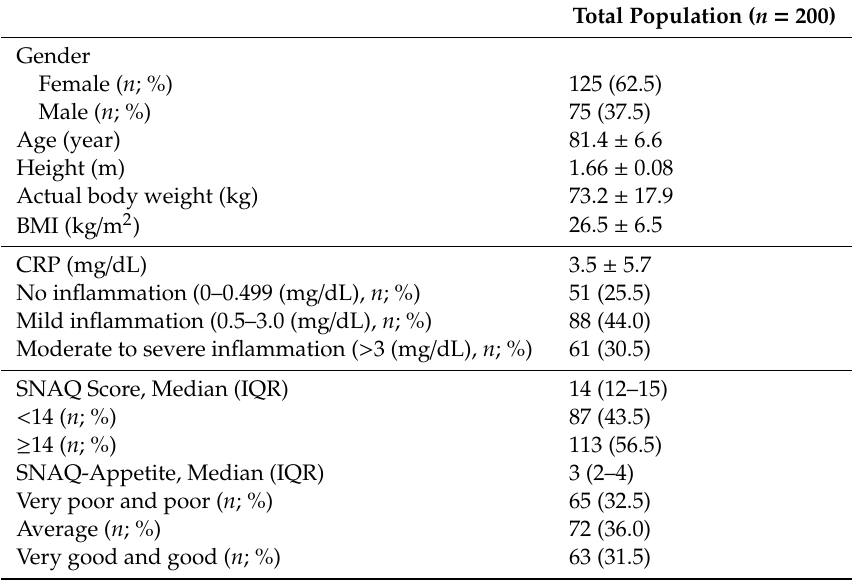
Table 1. Characteristics of the study